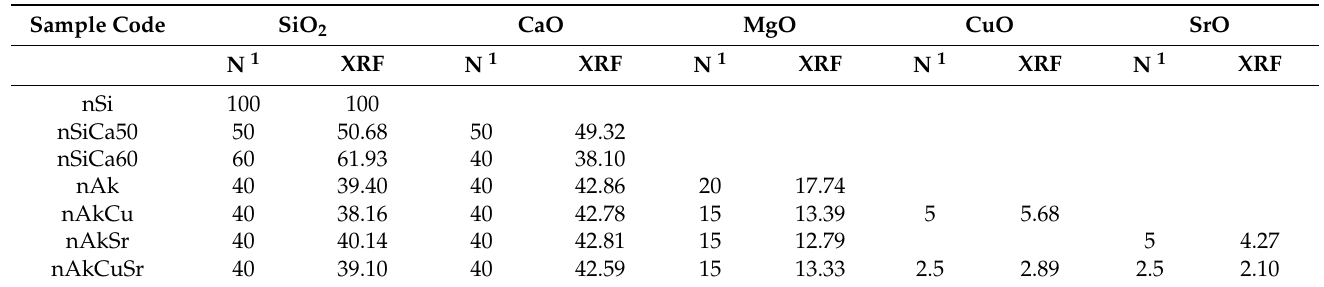
Table 4. Chemical composition of the synthesized NPs as detected by XRF in